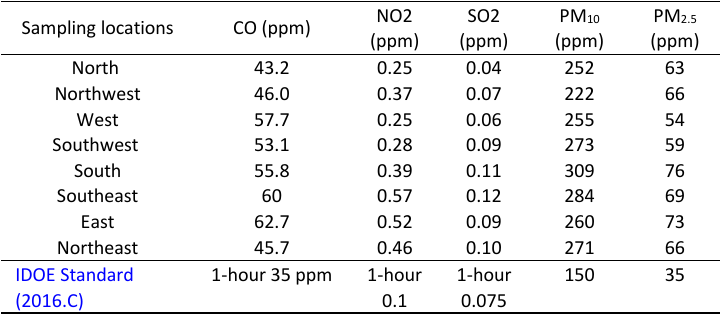
Table 3: Results of measuring air pollutants over Tehran West Bus Terminal on March 17, 2017 between 7-10 a.m.